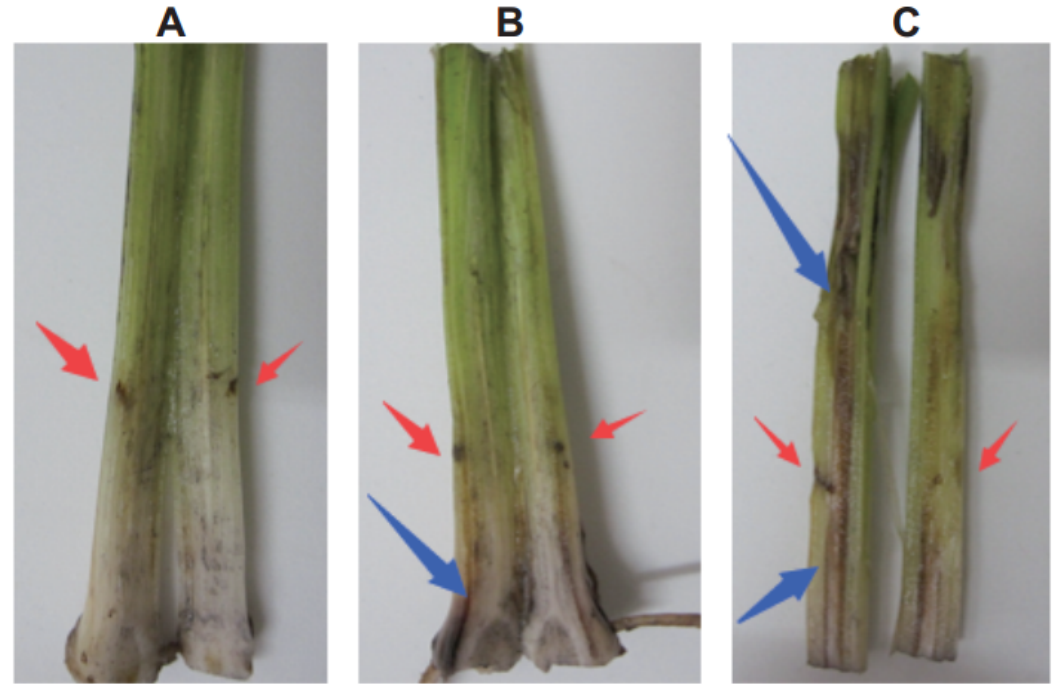
Figure 6. Tissue necrosis analysis of a Cavendish banana stem. ( A ): Plants injected with water control; ( B ): plants injected with r-Foc1-Pgc4; ( C ): plants injected with r-Foc4-Pgc4. Each plant was injected with 1 U of enzyme. Each treatment was cut for observing vascular necrosis after five days.